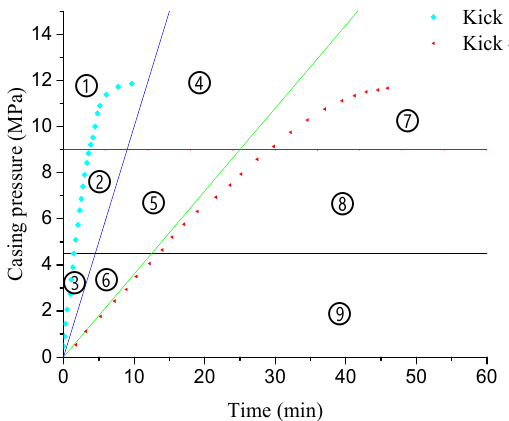
Figure 8. Kick severity analysis chart during the well shut-in period.